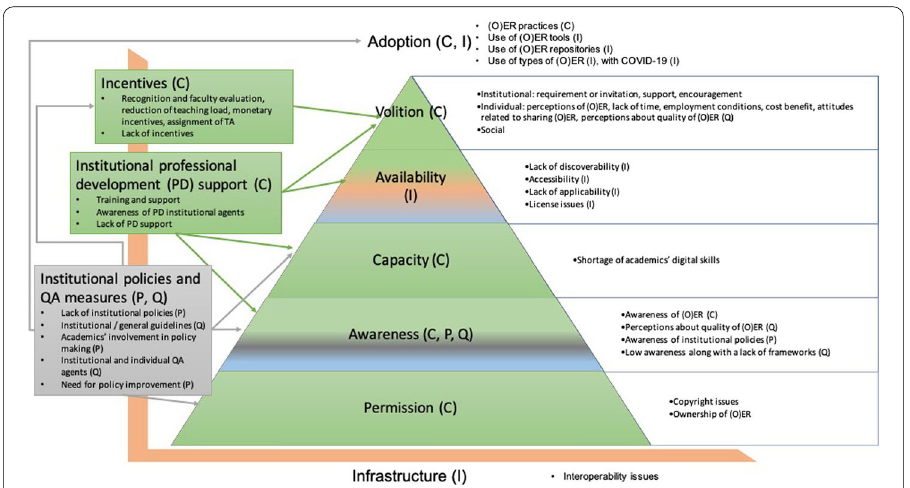
Fig. 3 Enhanced OER adoption pyramid combined with infrastructure (I), policy (P), quality (Q) and change (C). Note The differentiation between the four aspects is done using parenthesis and